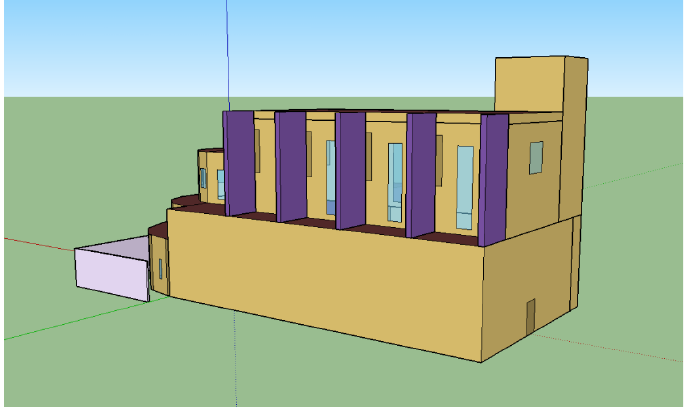
Figure 13. View of the North façade of the cathedral. Own elaboration with SketchUp.